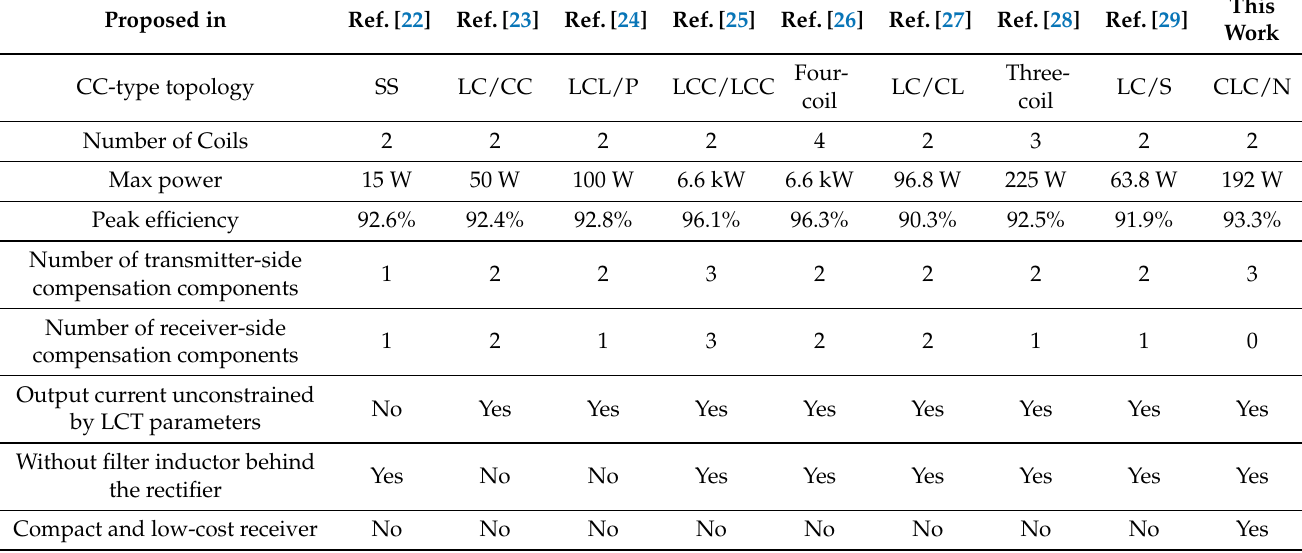
Table 6. Comparison results of this work with previous related